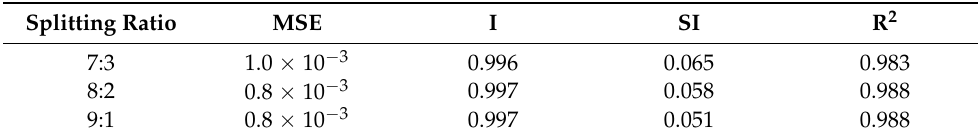
Table 3. Performance of machine learning model according to splitting a dataset.